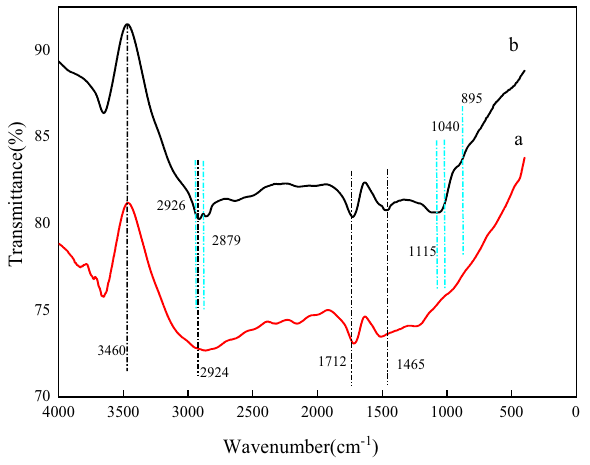
Figure 1. FTIR spectra analysis of HHF (a) and HHF-PODS (b).